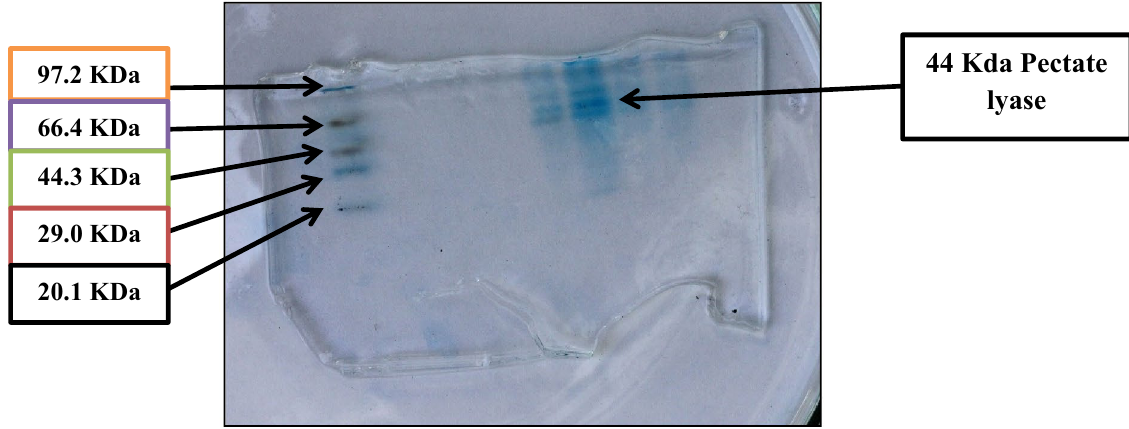
Figure 9. SDS–polyacrylamide gel electrophoresis of pectate lyase from Paenibacillus lactis PKC5.